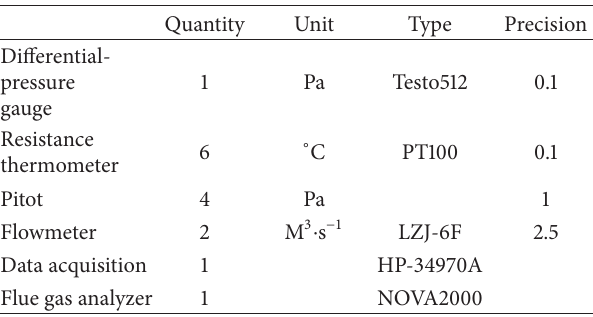
Table 5: Measuring